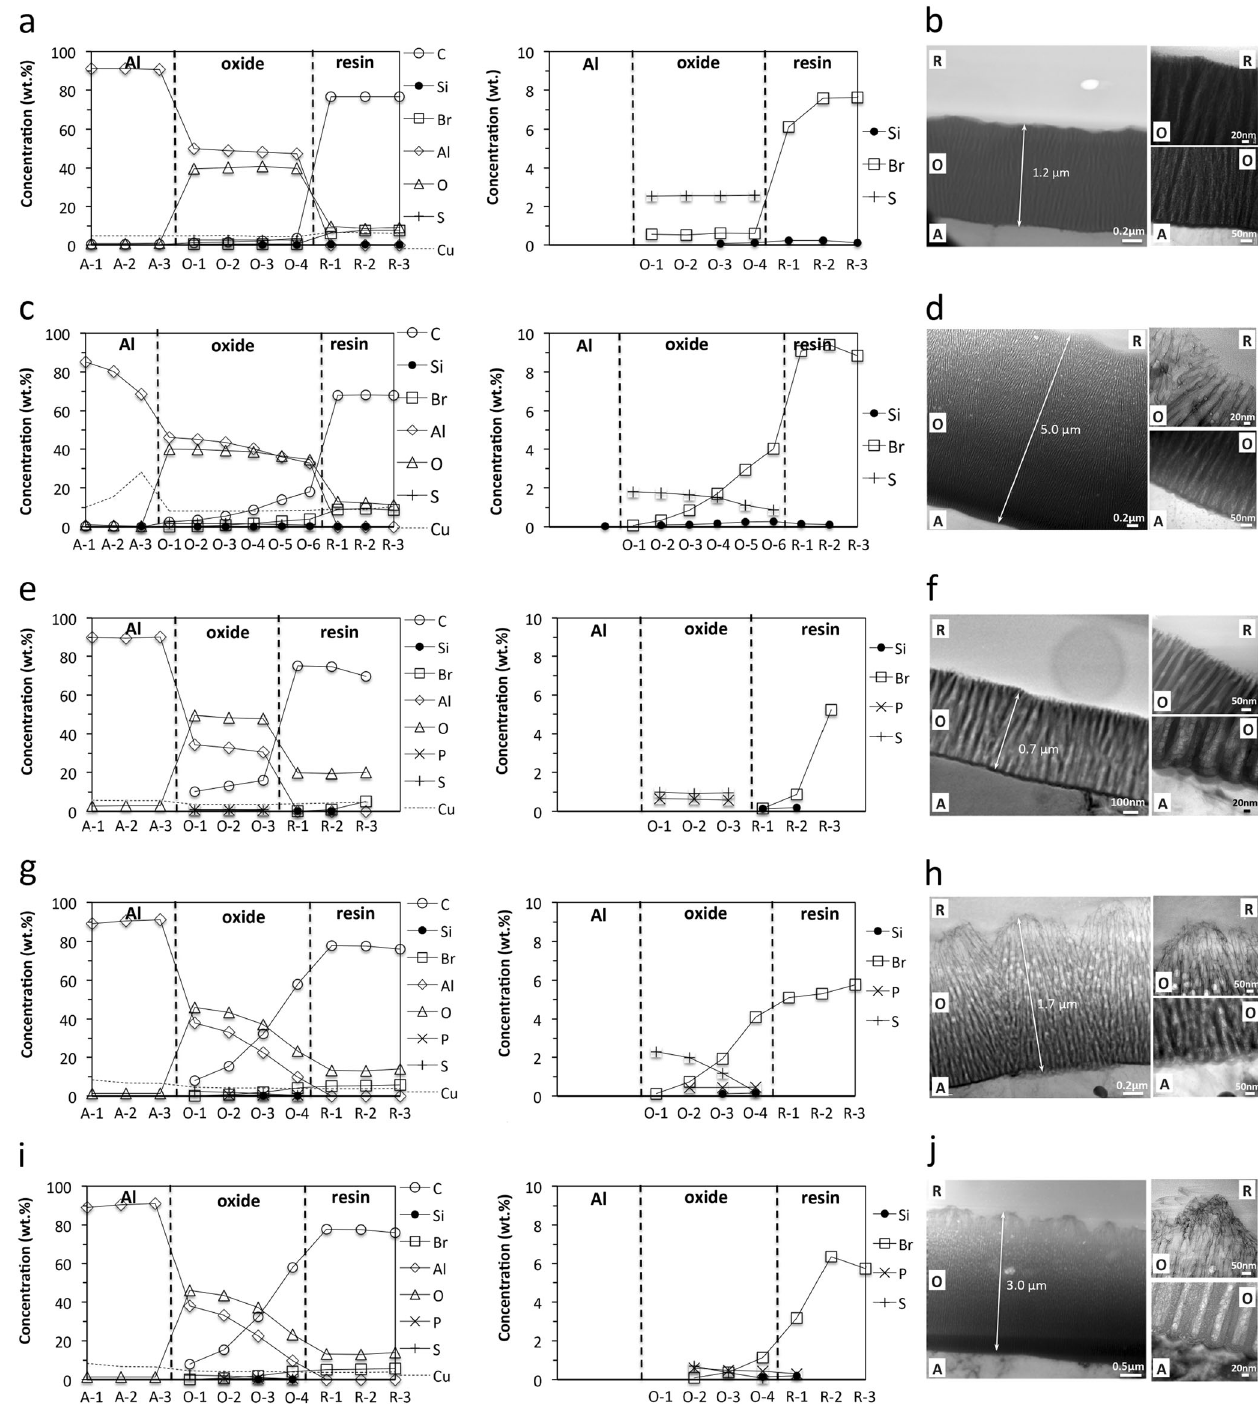
Fig. 2 TEM-EDS concentration pro fi les ( left column ) and a closer look at selected low-concentration elements ( middle column ). Notice that due to differences in oxide thickness, the last measurements within an oxide, as well as the distance within two points differ between specimens. On the right : the corresponding bright fi eld TEM micrographs of the fi ve selected oxides. For each TEM image: a complete cross-section ( large ) and zoom-in at the top and bottom part of the oxide ( smaller images ) are shown. Anodizing conditions: a , b SAA20, c , d SAA50, e , f PSA20, g , h PSA35, and i , j